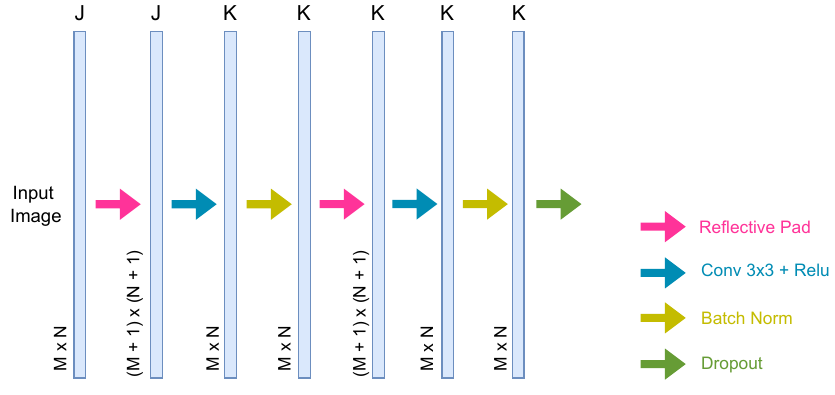
Figure 4. Convolutional block